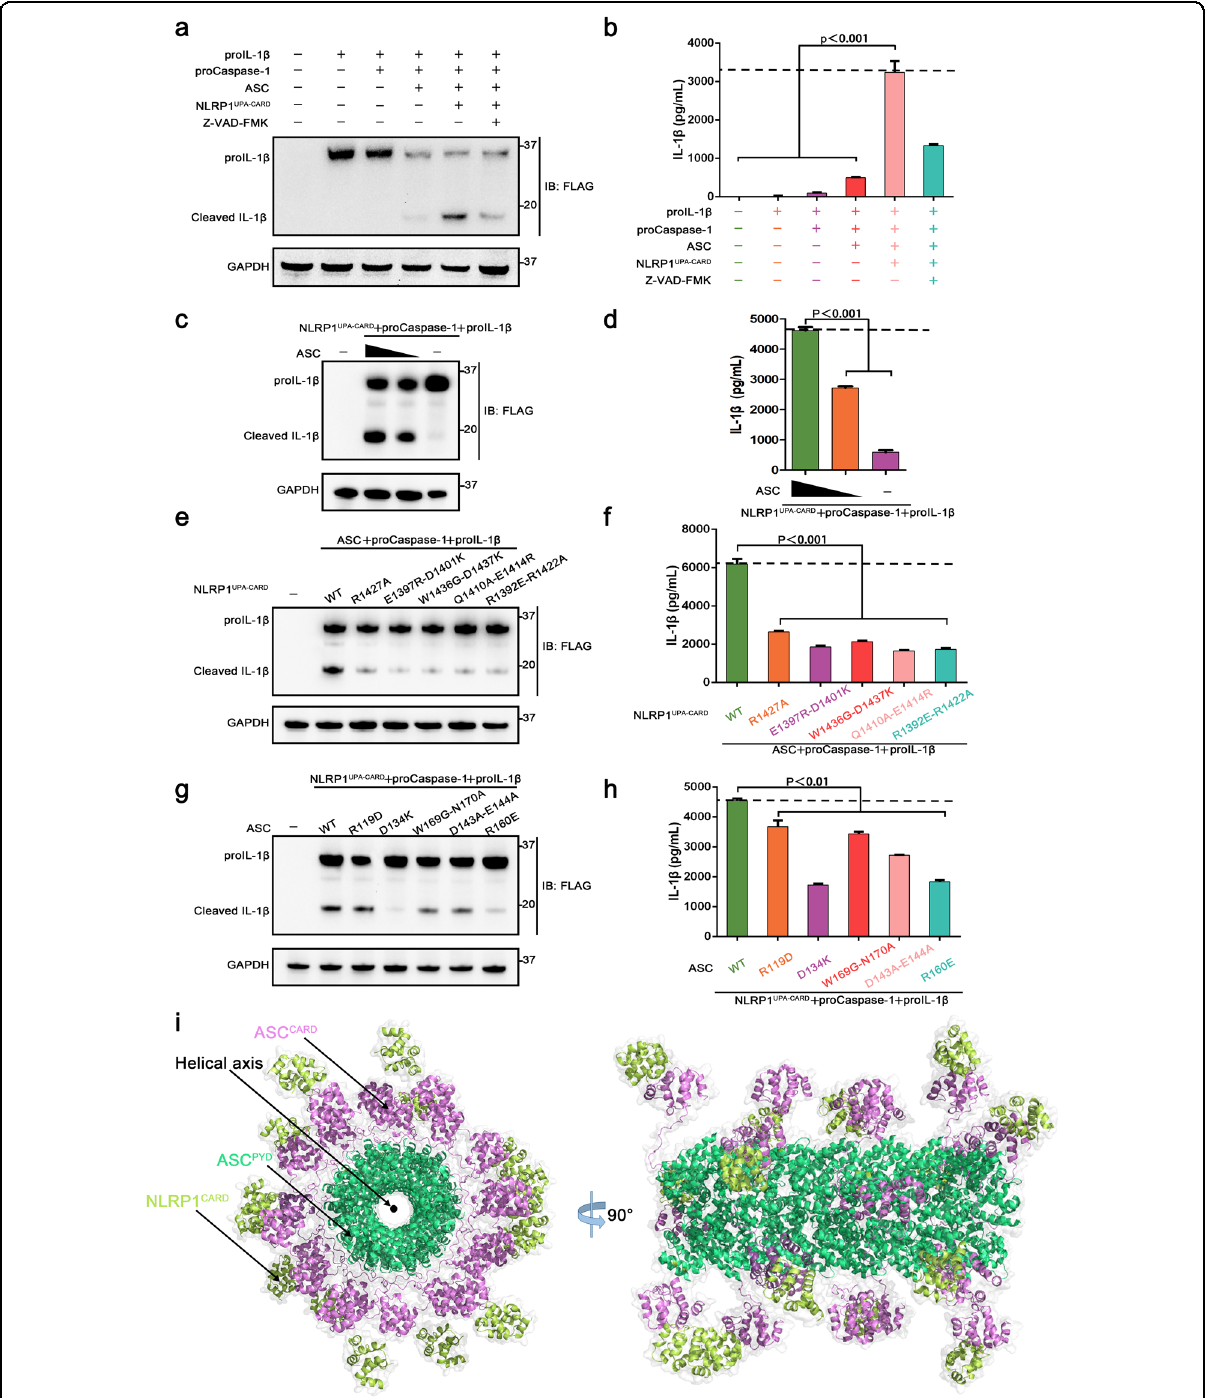
Fig. 5 Three asymmetric interaction types of CARD are veri fi ed with key functional roles in NLRP1 in fl ammasome activation. a , b Reconstitution of NLRP1 in fl ammasome in HEK293T cells. In fl ammasome was activated by co-expression of the UPA-CARD fragment of NLRP1 and was monitored by immunoblot (IB) or ELISA for cleaved IL-1 β . Mean values±SEM are representative of three independent experiments. c , d Western blotting and ELISA analysis for cleaved IL-1 β from ASC-de fi cient NLRP1 in fl ammasome. Mean values±SEM are representative of three independent experiments. e , f Western blotting and ELISA analysis for cleaved IL-1 β from wild-type NLRP1 and NLRP1 mutations in NLRP1 in fl ammasome. Mean values±SEM are representative of three independent experiments. g , h Western blotting and ELISA analysis for cleaved IL-1 β from wild-type ASC and ASC mutations in NLRP1 in fl ammasome. Mean values±SEM are representative of three independent experiments. i Structure model for the fi lament co-assembly of NLRP1 CARD and ASC in the complex. The top view is shown schematically at the left and the side view is shown schematically at the